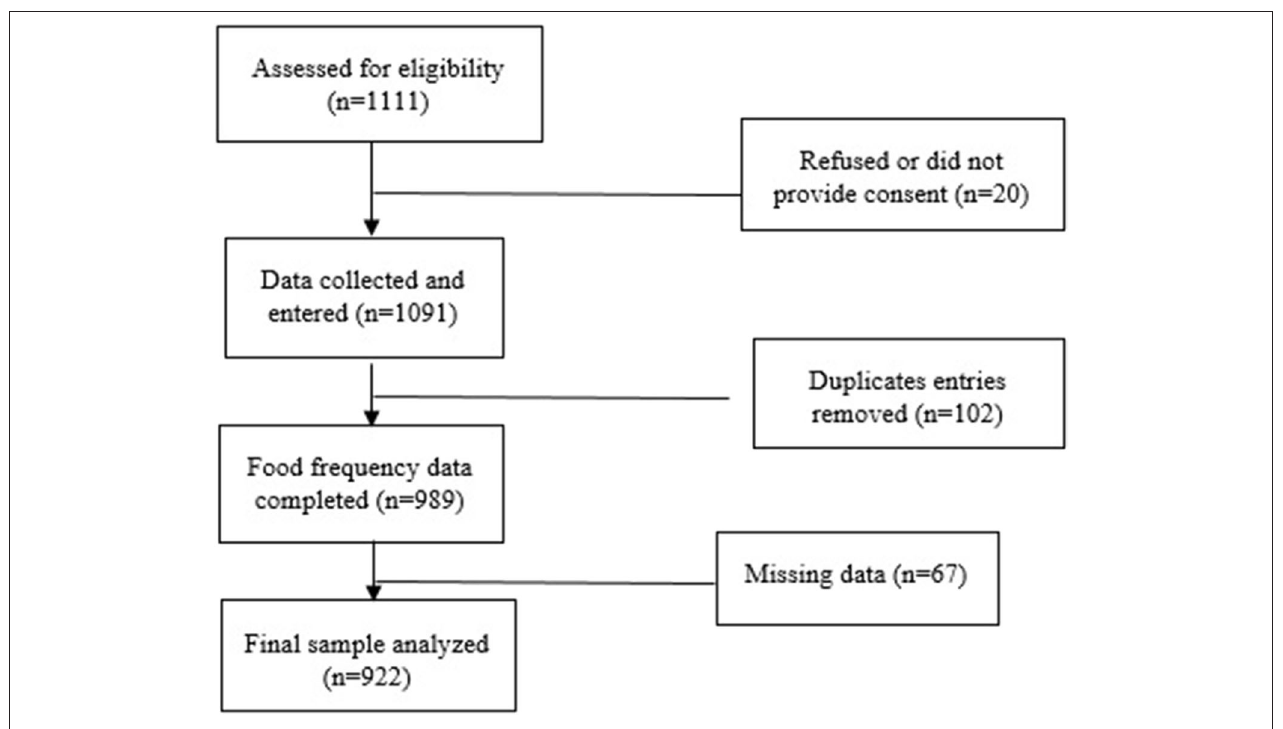
FIGURE 1 | Flowchart of participant progression through the dietary survey across 4 districts of India.